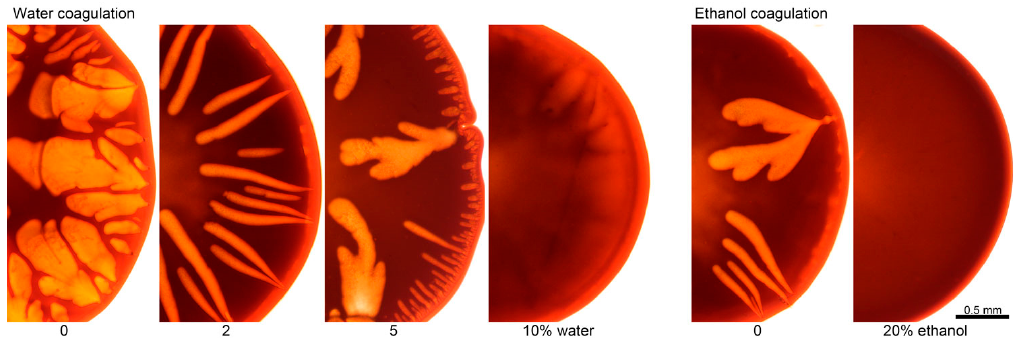
Figure 18. The drops morphology of PANI-O solutions containing di ff erent amounts of water and ethanol, coagulated by appropriated coagulant.